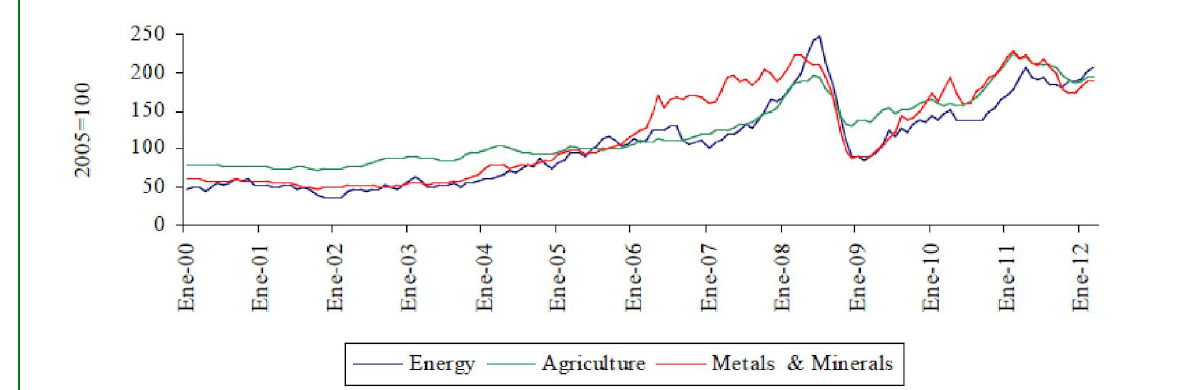
Figure 1: Evolution of commodities prices (Klimovsky 2012 based on World Bank data).